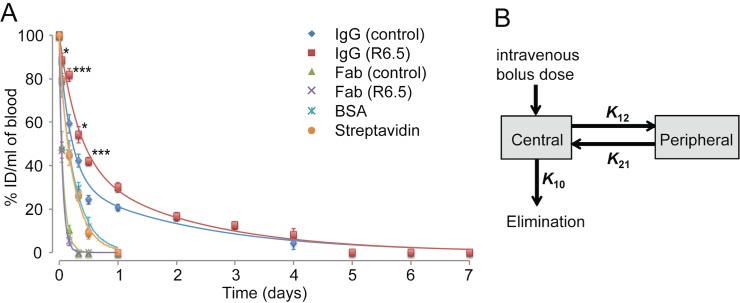
Measurement of imaging agent concentration in blood to estimate pharmacokinetic parameters.(A) The concentration of each imaging agents in blood was measured by fluorescence, and plotted as a percentage of injected dose (%ID/mL) versus time (n = 3 for all except n = 6 for R6.5 and control IgG at 1, 4, 12 and 24 h postinjection with standard error of mean (SEM) as error bars). Two-way ANOVA followed by Bonferroni post-hoc test was used to evaluate statistical significance of responses of different imaging agents at different time points (S1 Table). Significant differences are indicated with *p < 0.05 and ***p < 0.001 for R6.5 versus control IgGs. (B) Schematic diagram describing a two-compartment pharmacokinetic model with rate constants is shown. Central compartment represents blood and well perfused organs (e.g., plasma), while peripheral represents poorly perfused tissues. K10, K12, and K21 represent, respectively, rate constants for elimination, distribution, and redistribution.